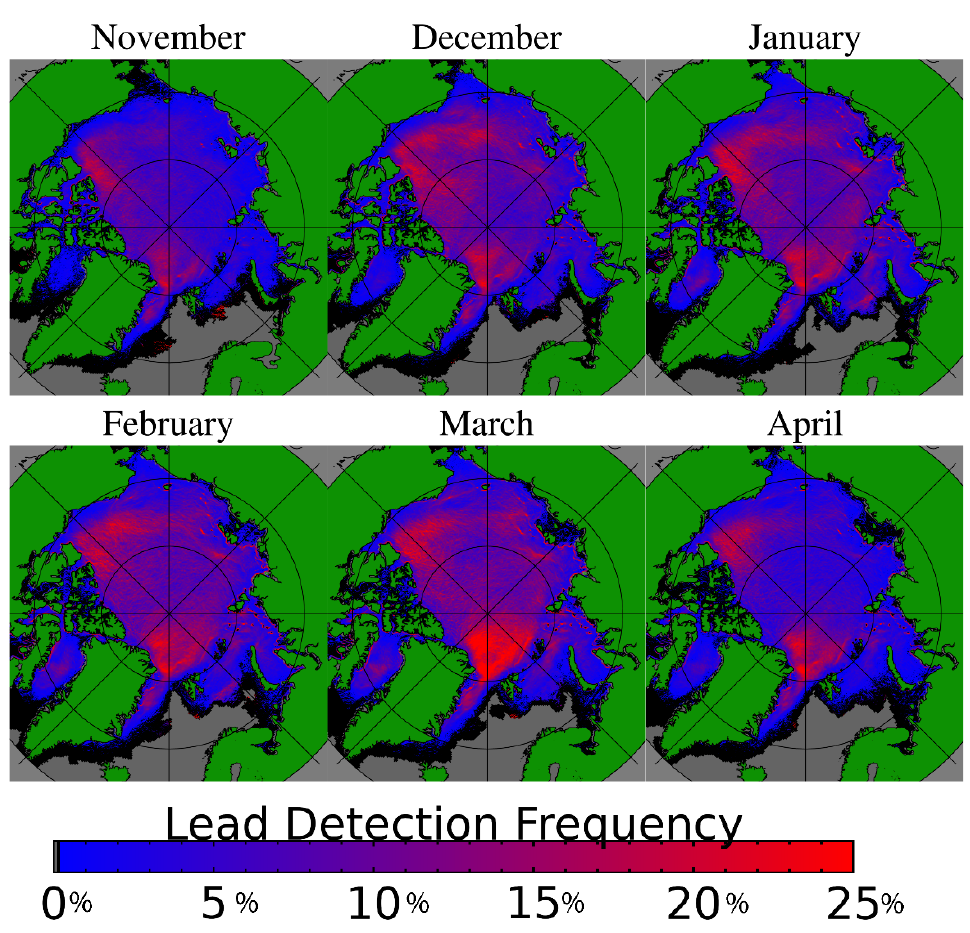
Figure 2. Winter lead frequency by month, reported as the aggregate percentage of each month, November through April, from 2002 to 2022.